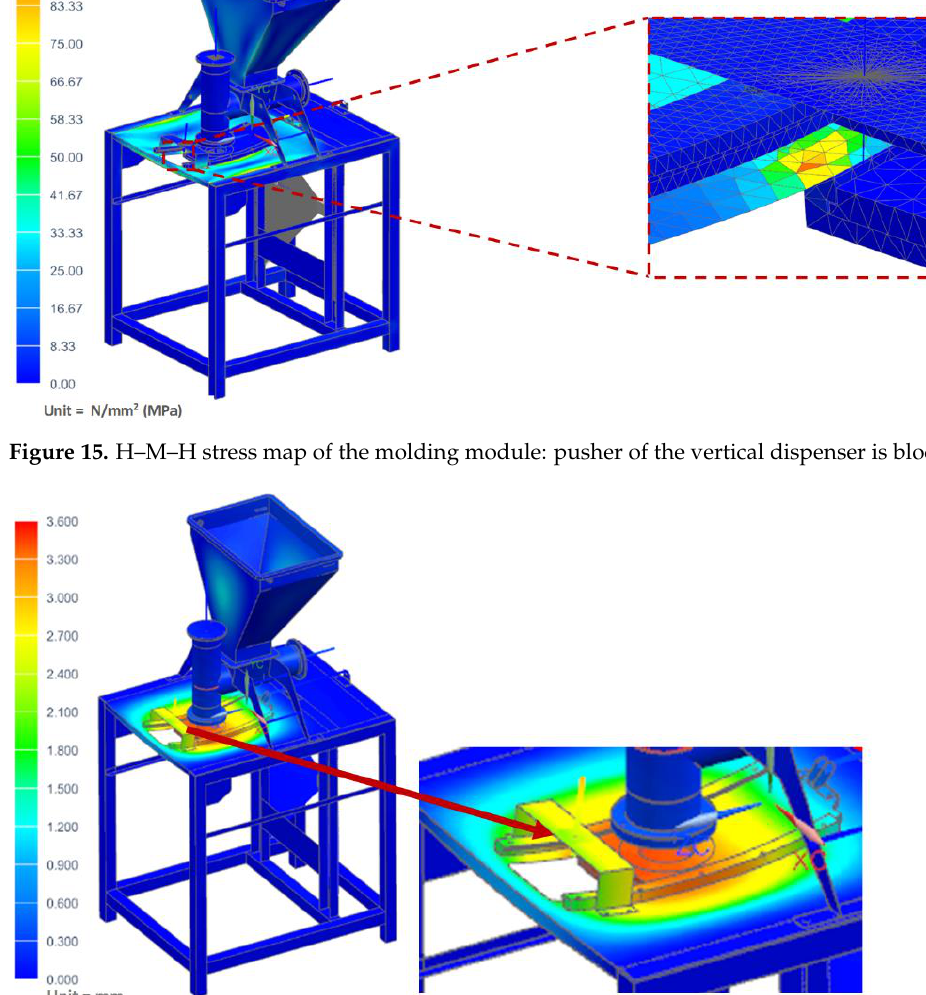
Figure 17. H–M–H stress map of the molding module: die assembly is locked in the runners.